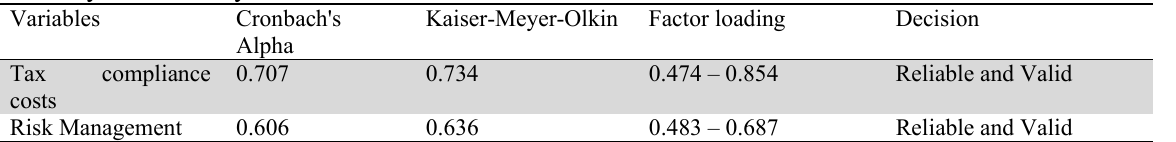
Reability and Validity